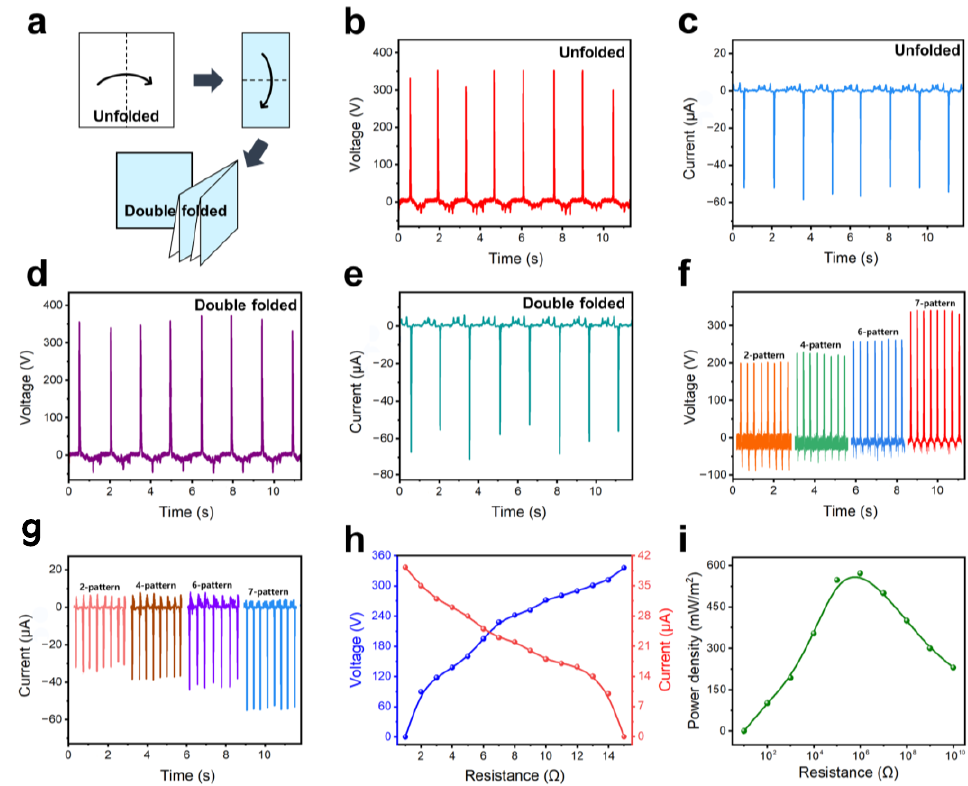
Figure 3. ( a ) Schematic of the unfolded and double-folded FP-TENG. Comparison of output voltage and current for ( b , c ) unfolded and ( d , e ) double-folded FP-TENG. ( f , g ) Output voltages and currents for different PTFE patterns. ( h ) Measured voltage and current results. ( i ) Power density across various loading resistors. Table 1. Comparison of existing triboelectric nanogenerators using paper.